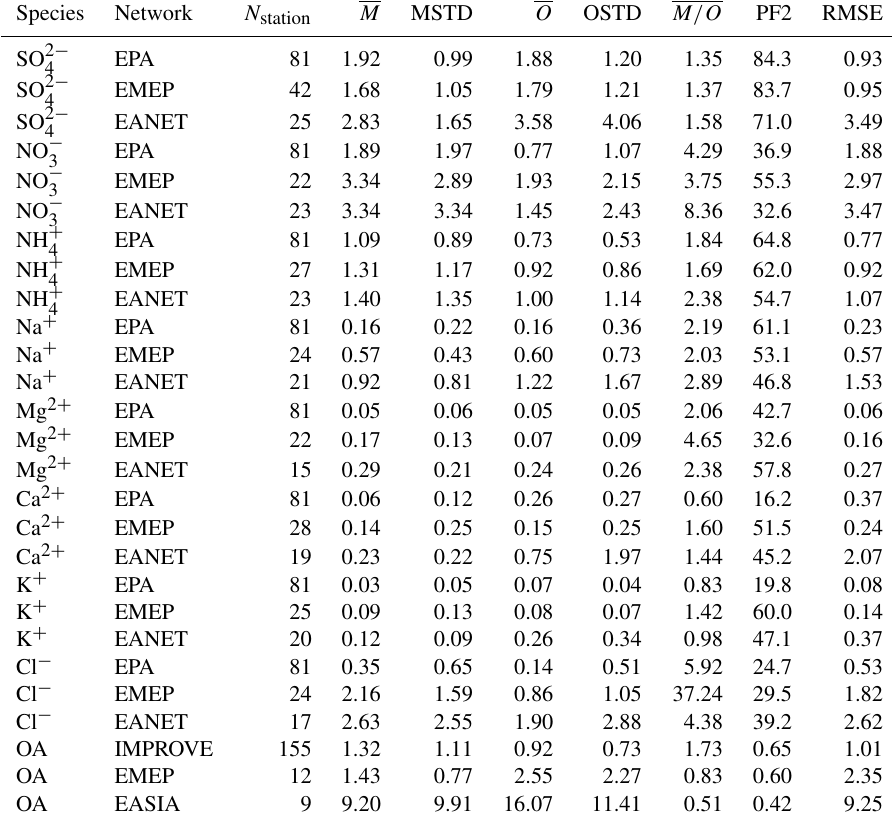
Table 6. Summary of simulated and observed monthly averaged aerosol concentrations for SO 2 − and organic aerosols (OA) and different observational networks (second column). N station is the number of stations providing data for the respective species and network; note that this is not the sample size for the shown statistics. The following columns provide the arithmetic mean of the simulated ( M ) and observed concentrations ( O ) and the respective standard deviations (MSTD, OSTD, in µgm − 3 ). PF2 denotes the percentage of simulated points within a factor of 2 with respect to the observations, and RMSE represents the root-mean-square error between simulated and observed